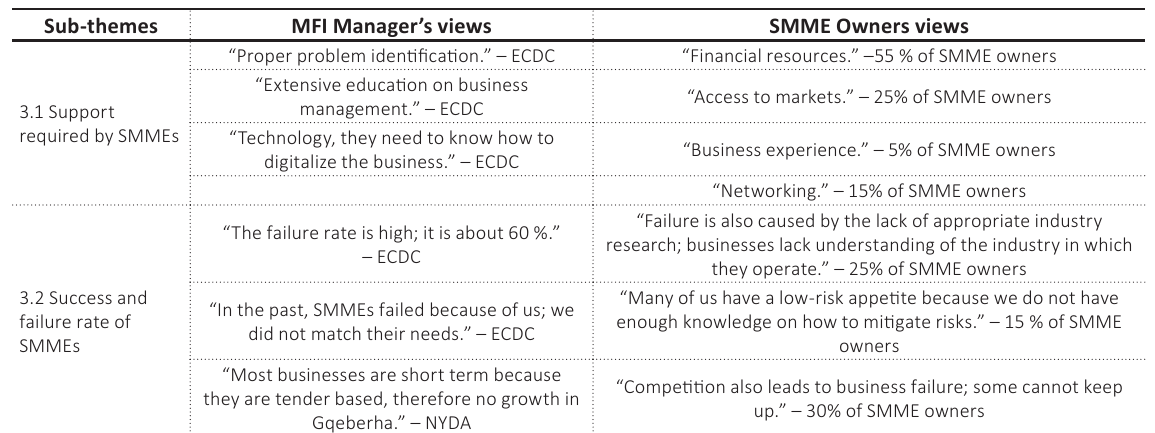
Table 3. SMME owners’ experience with